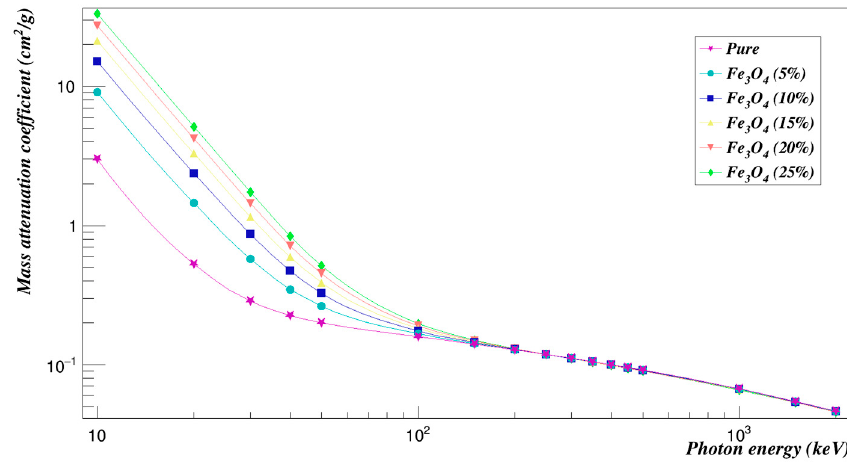
Figure 6. Photon mass attenuation coefficients of Polyimide doped with iron oxide.